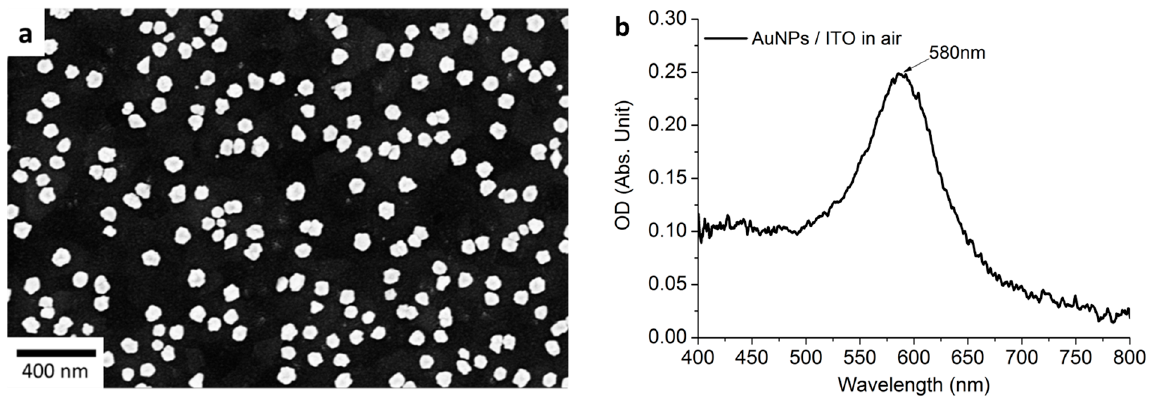
Figure 2. ( a ) The SEM image of deposited AuNPs and ( b ) corresponding extinction spectra.